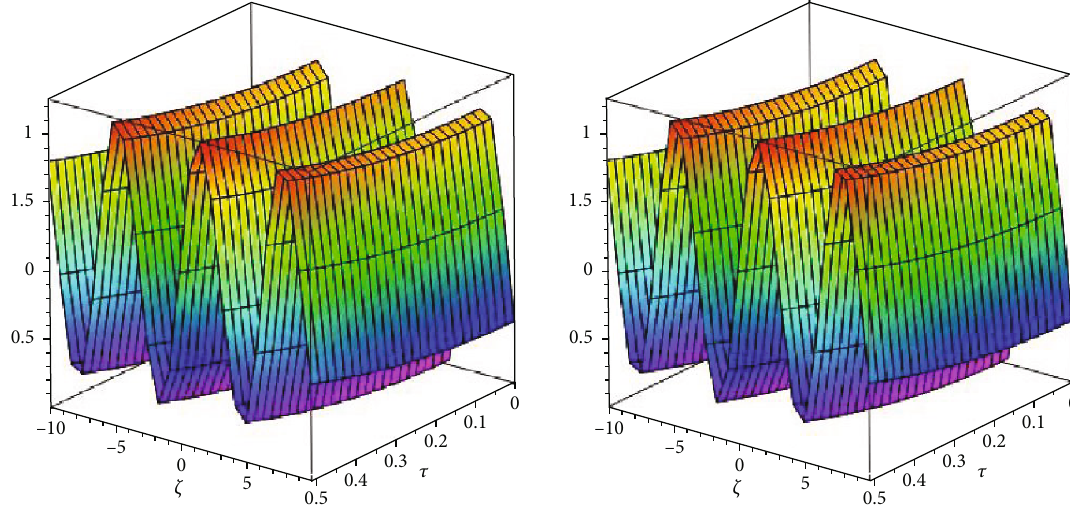
Figure 3: The exact and an approximate graph of problem 2.